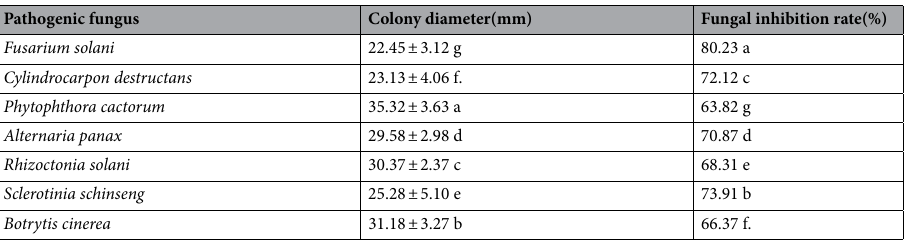
Table 1. Inhibition of activity of Frankia F1 against pathogenic fungi of ginseng. All the presented values are means of three replicates. Means were subjected to analysis of variance and were separated by the LSD test. Letters represent the significant differences among the mean values and the “ ± ” is followed by the standard error values of the means.